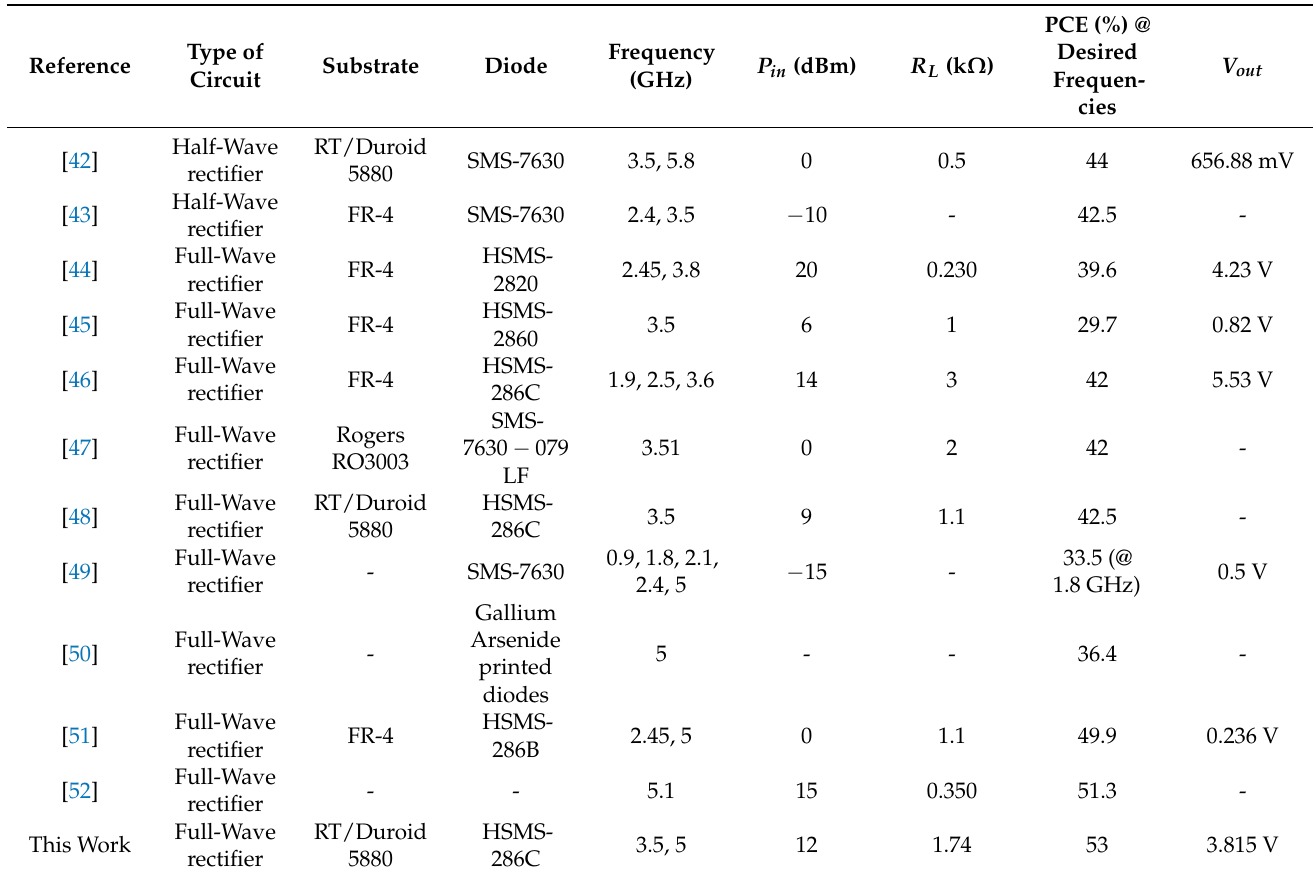
Table 2. Comparative results between proposed dual-band rectifier and previous